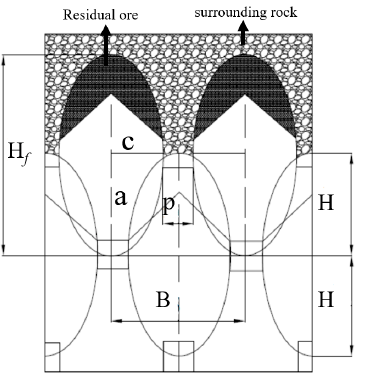
Figure 1. Arrangement of large space of discharged ellipsoid.